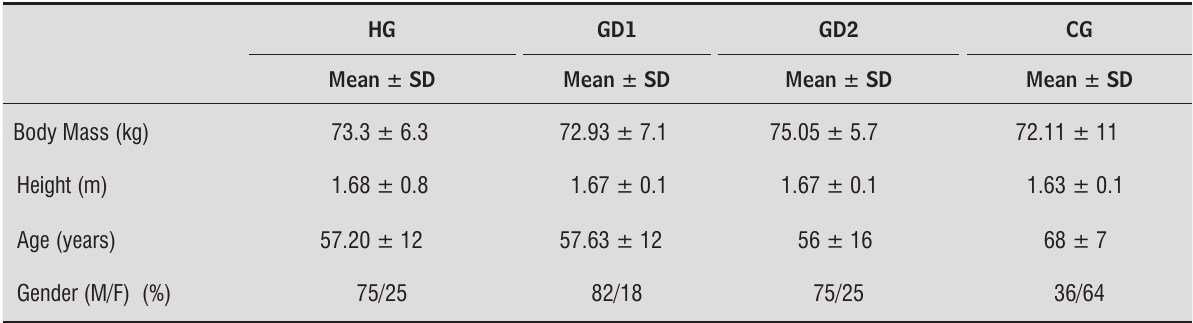
Table 1 - Characteristics of the